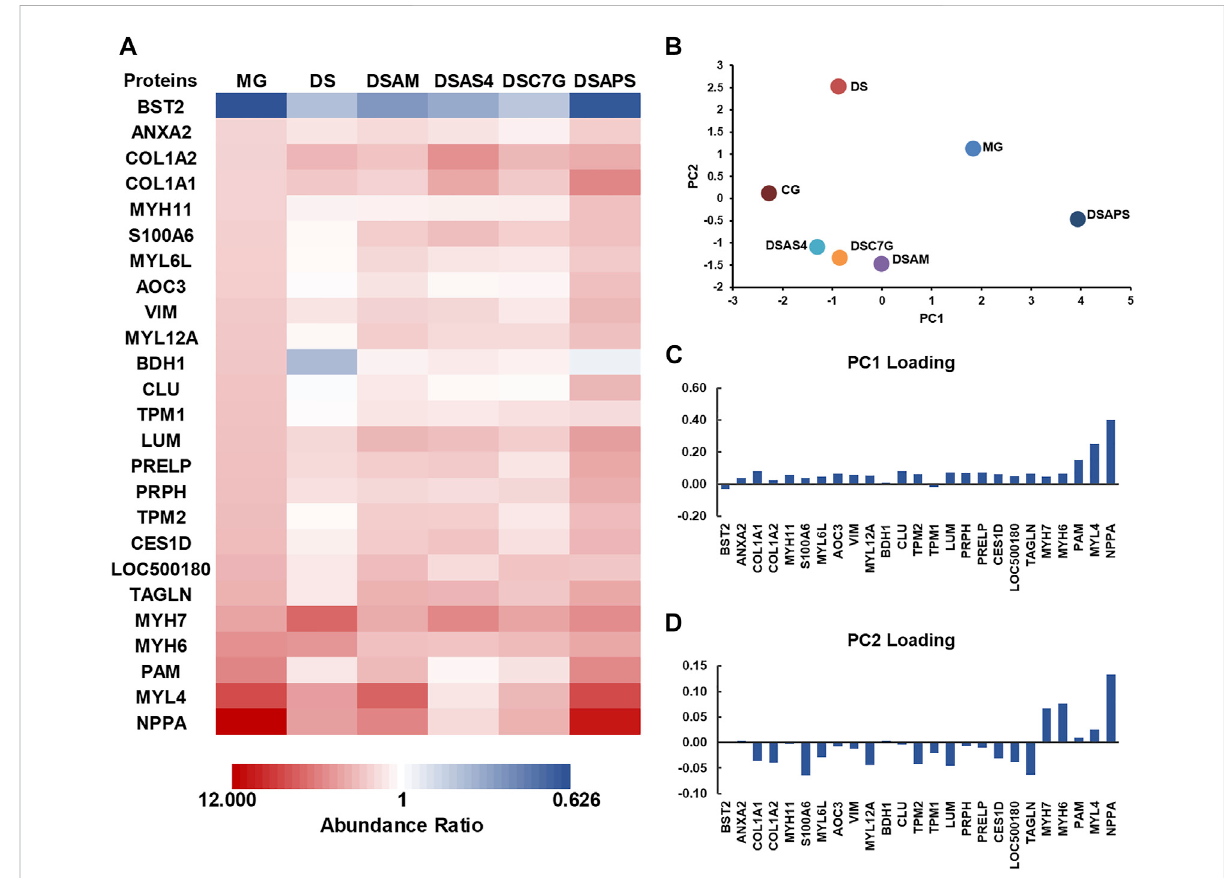
FIGURE 5 Differentially expressedproteins (DEPs) weredetected in the heart of rats with ISO-iCM before and after treatments,comparedto thecontrols. (A) Abundance ratios (model or treated groups vs. control group) of 25 DEPs in the model group (MG), treated group with Descurainia sophia seed decoction alone (DS), and Descurainia sophia seeds plus Astragalus mongholicus decoction (DSAM), Descurainia sophia seed decoction plus astragaloside IV (DSAS4), calycosin-7-glucoside (DSC7G), or astragalus polysaccharides (DSAPS). (B) Principal component analysis (PCA) is based on 213 proteinsidenti fi edin all groups with a p -value < 0.05. (C,D) Loading scores discriminate the model (MG) and treated groups, DS,DSAM, DSAS4, DSC7G, and DSAPS, over the control group